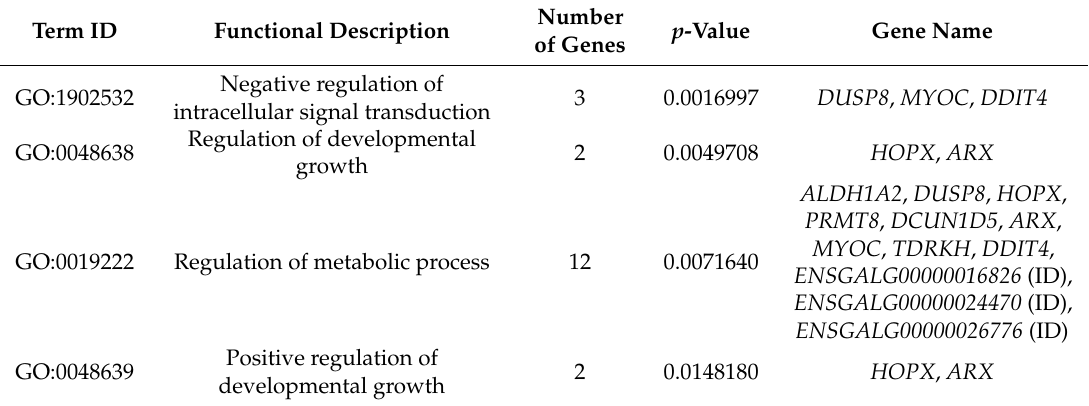
Table 7. The significantly enriched biological process terms for the eight-week-old females.